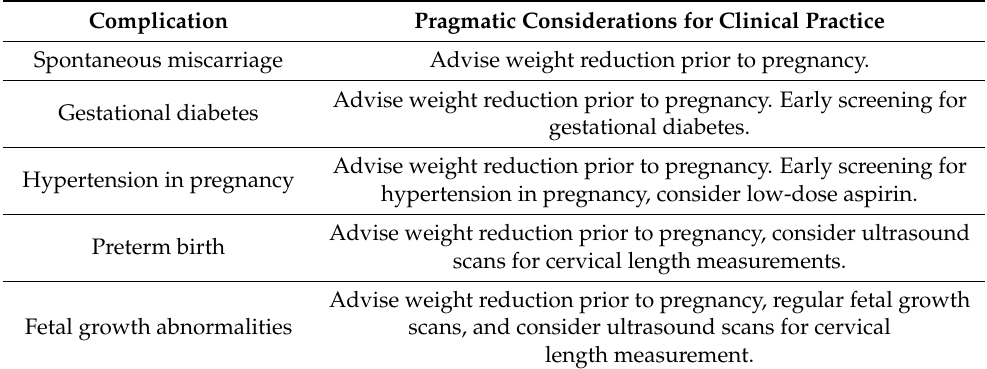
Table 2. Potential pregnancy complications in PCOS and implications for clinical